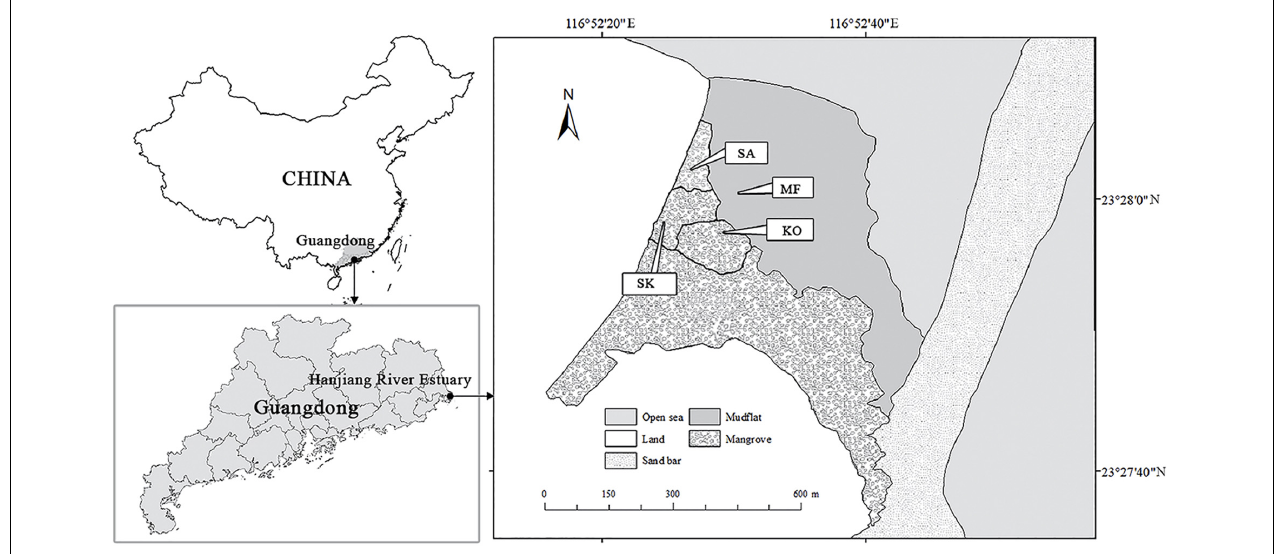
FIGURE 1 | Locality of the study mangrove forests at Hanjiang River Estuary, Guangdong Province, southern China.